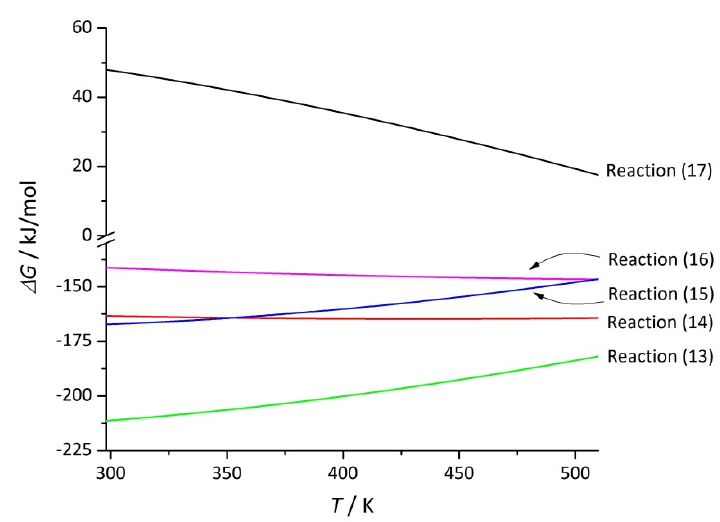
Figure 1. Temperature dependences of changes in the Gibbs energy. Each curve corresponds to the individual reaction.